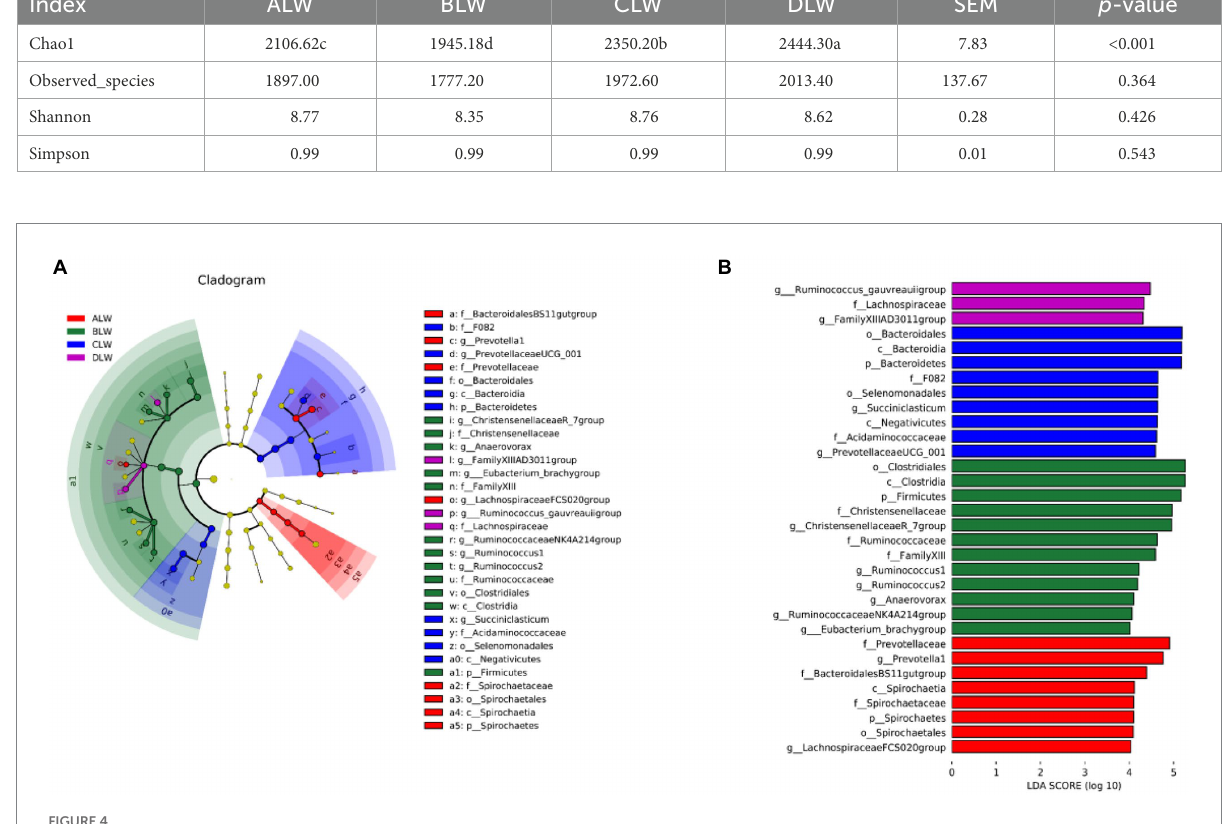
FIGURE 4 (A) Evolution cladogram (B) LDA score chart, LDA value >4, p < 0.05.